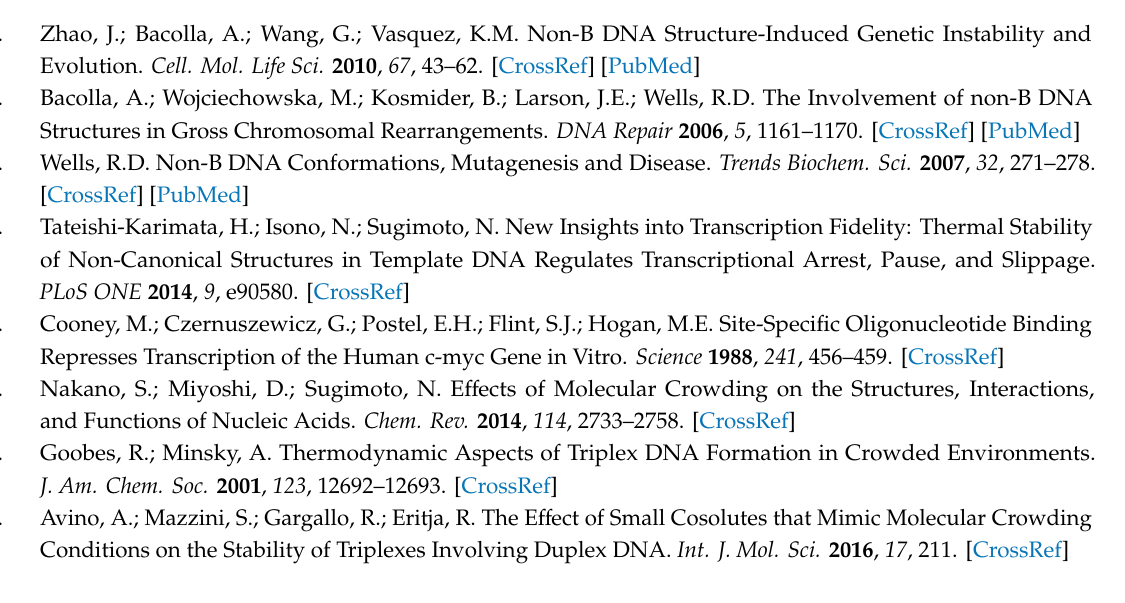
Supplementary Materials: The following are available online, Figure S1: The normalized UV melting curves of Intra-CG2, Intra-CG4, Intra-CG6, Hp-CG2 + T-CG2, Hp-CG4 + T-CG4, and Hp-CG6 + T-CG6 at 295 nm in a bu ff er containing 50 mM 2-morpholino-ethanesulfonic acid (MES) at pH 6.0 in the absence of PEG 200 and K + . Figure S2: (a–c) Melting curves of Intra-CG2, Intra-CG4, and Intra-CG6 at 260 nm in bu ff ers containing 50 mM MES (pH 6.0 at 25 ◦ C) and 0, 0.1, 0.5, 1.0, and 1.5 M KCl in the absence of crowding agents. (d–f) Melting curves of Intra-CG2, Intra-CG4, and Intra-CG6 at 295 nm in bu ff ers containing 50 mM MES (pH 6.0 at 25 ◦ C) and 0, 0.1, 0.5, 1.0, and 1.5 M KCl in the absence of crowding agents. Figure S3: Melting curves of (a–c) Hp-CG2 + T-CG2, Hp-CG4 + T-CG4, and Hp-CG6 + T-CG6 at 260 nm in bu ff ers containing 50 mM MES (pH 6.0 at 25 ◦ C) and 0, 0.1, 0.5, 1.0, and 1.5 M KCl in the absence of crowding agents, (d–f) Hp-CG2 + T-CG2, Hp-CG4 + T-CG4, and Hp-CG6 + T-CG6 at 295 nm in bu ff ers containing 50 mM MES (pH 6.0 at 25 ◦ C) and 0, 0.1, 0.5, 1.0, and 1.5 M KCl in the absence of crowding agents. Figure S4: (a–c) Melting curves of Intra-CG2, Intra-CG4, and Intra-CG6 at 260 nm in the bu ff ers containing 50 mM MES (pH 6.0 at 25 ◦ C) and 0, 0.1, 0.5, 1.0, and 1.5 M KCl in the presence of 40 wt% PEG 200. (d–f) Melting curves of Intra-CG2, Intra-CG4, and Intra-CG6 at 295 nm in the bu ff ers containing 50 mM MES (pH 6.0 at 25 ◦ C) and 0, 0.1, 0.5, 1.0, and 1.5 M KCl in the presence of 40 wt% PEG 200. Figure S5: (a–c) Melting curves of Hp-CG2 + T-CG2, Hp-CG4 + T-CG4, and Hp-CG6 + T-CG6 at 260 nm in bu ff ers containing 50 mM MES (pH 6.0 at 25 ◦ C) and 0, 0.1, 0.5, 1.0, and 1.5 M KCl in the presence of 40 wt% PEG 200. (d–f) Melting curves of Hp-CG2 + T-CG2, Hp-CG4 + T-CG4, and Hp-CG6 + T-CG6 at 295 nm in bu ff ers containing 50 mM MES (pH 6.0 at 25 ◦ C) and 0, 0.1, 0.5, 1.0, and 1.5 M KCl in the presence of 40 wt% PEG